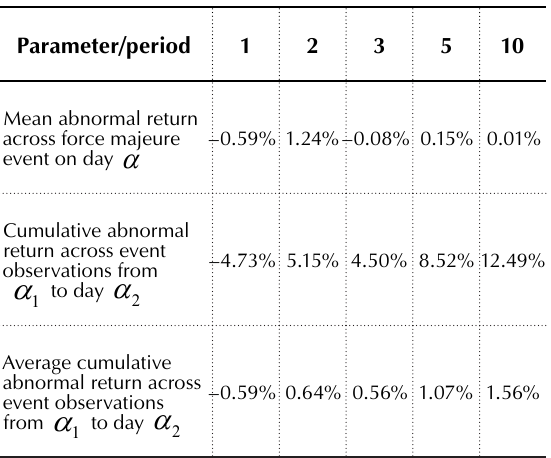
Table 2. Cumulative abnormal returns for the PFST index over the period 1997–2018: